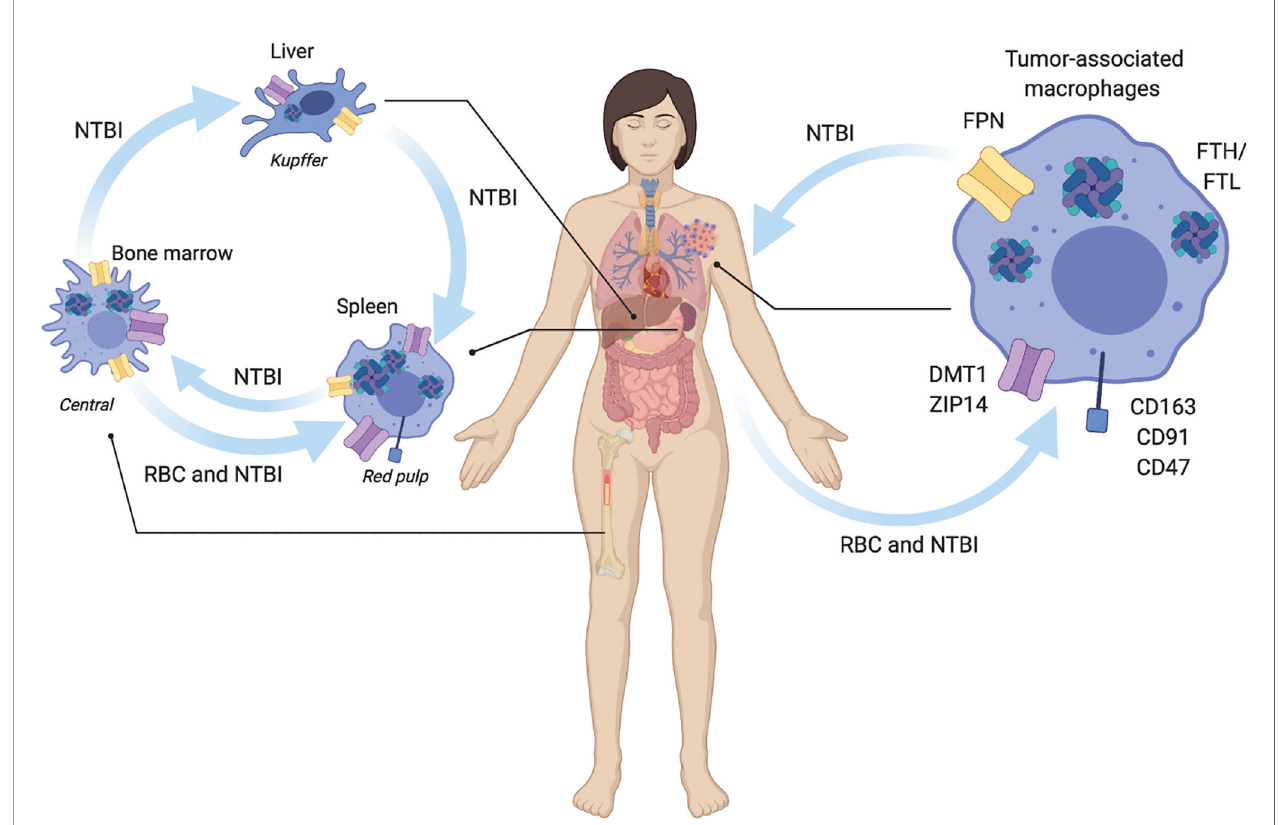
FIGURE 1 | Macrophage regulation of systemic iron metabolism. Macrophages are central regulators of iron metabolism systemically throughout the body where they regulate largely unidirectional fl ux of non-transferrin bound iron NTBI, and red blood cell (RBC) erythrophagocytosis. Macrophages across the body and in tumors share similar uptake, storage and release mechanisms. NTBI iron is taken up by ZIP14, and DMT1. RBC are recognized for phagocytosis via CD163, CD91, and CD47 receptors. NTBI is stored as ferritin heavy chain (FTH) and light chain (FTL) complexes. NTBI is released by ferroportin (FPN). In liver Kupffer cells integrate in fl ammatory cues with NTBI iron recycling to regulate iron homeostasis. Spleen red-pulp macrophages respond to systemic metabolic iron needs by phagocytosis of senescent red blood cells (RBC) and export of recycled NTBI. Bone marrow central macrophages process NTBI received from the periphery to support heme synthesis during erythropoiesis. In the tumor, tumor associated macrophages similarly recycle NTBI and